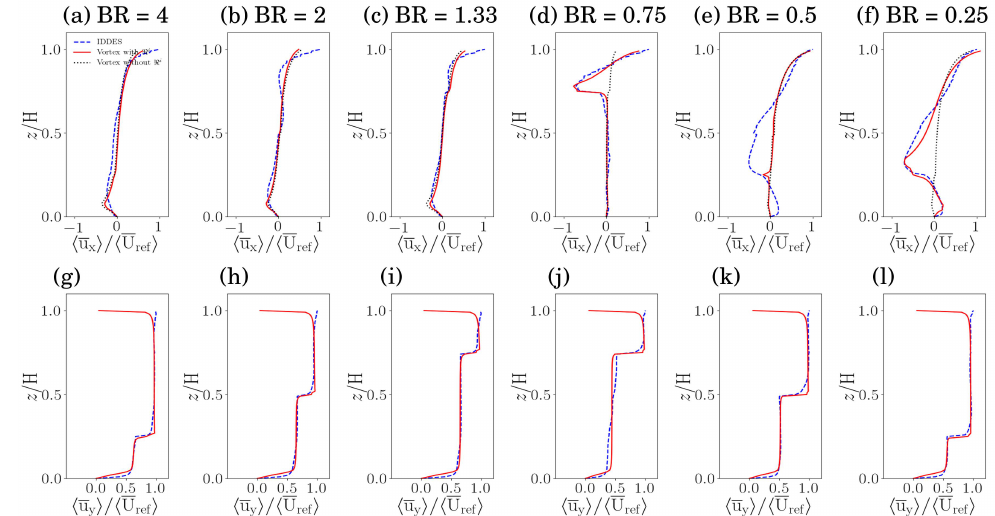
Figure 10. Vertical profiles of normalised velocities for step-up ( BR > 1) and step-down ( BR < 1) canyons and θ = 45°. ( Top ) u x ; ( bottom ) u y . Predictions with (solid red line) and without (dotted black line) the intermediate vortex sheet located on top of the lower building are compared to IDDES (dashed blue